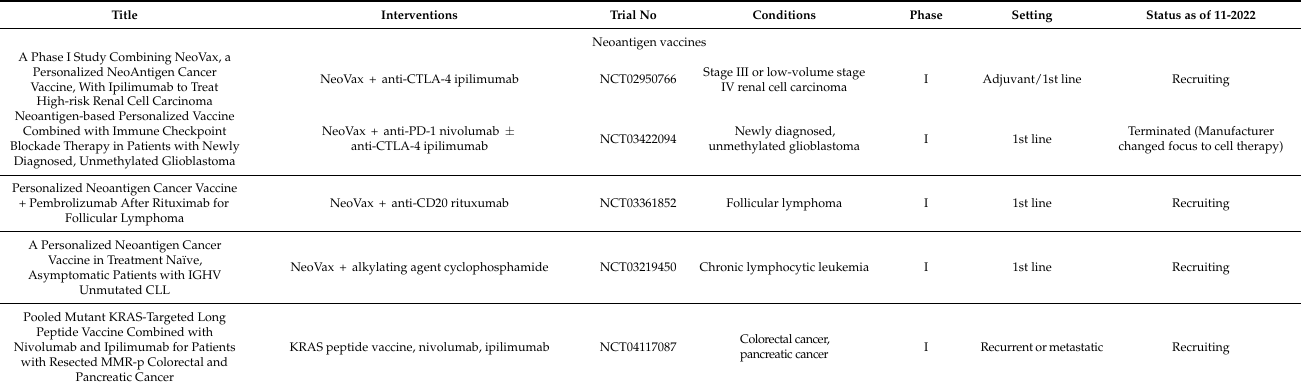
Table 5. Representative examples of ICI therapy in combination with other drugs to overcome